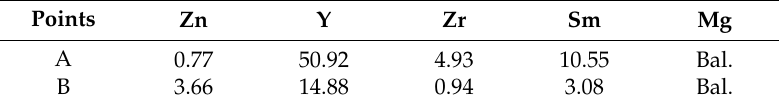
Table 6. EDS results corresponding to the selected points in Figure 9 (at %).